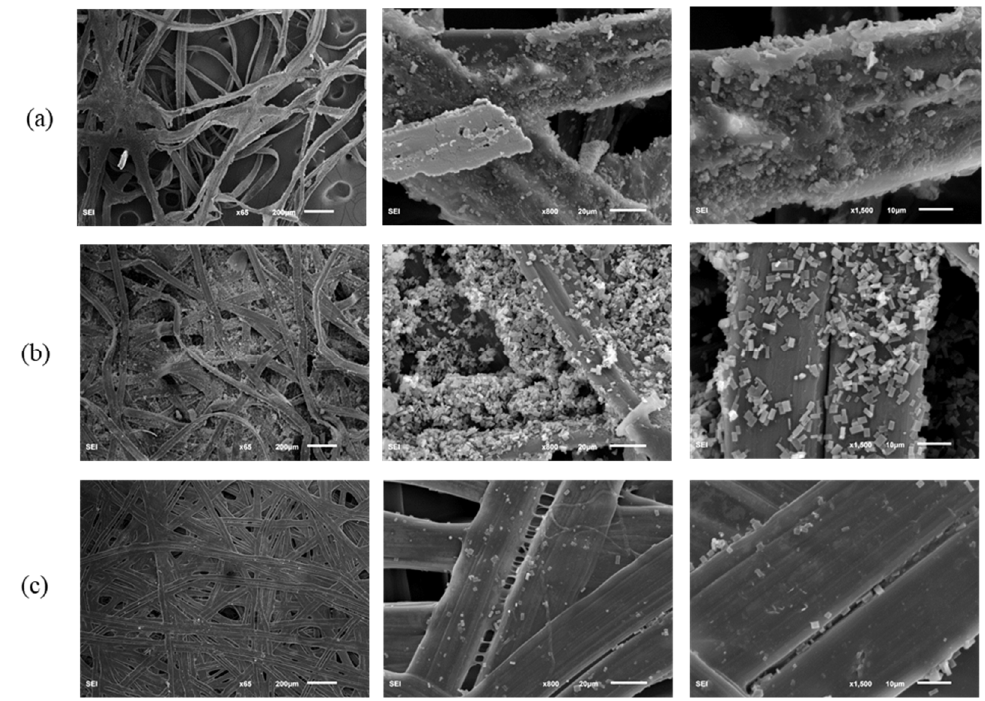
Figure 7. The micro-structure of different cocoon layers from A. pernyi (L): ( a ) outer layer, ( b ) middle layer, ( c ) inner layer.